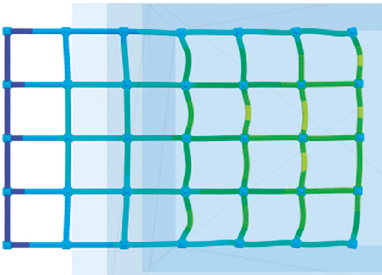
Figure 11: Schematic of the morphology of the geogrid after the pull-out